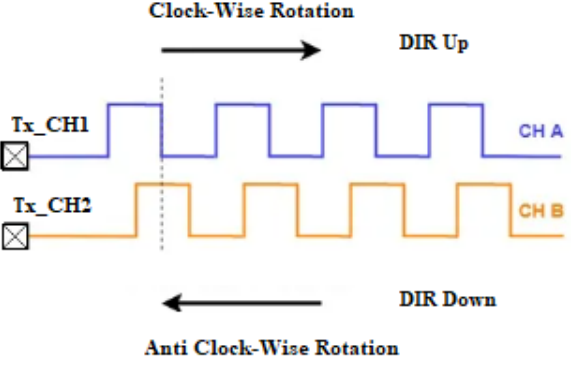
Figure 11. Recording the direction of rotation in the DIR register.